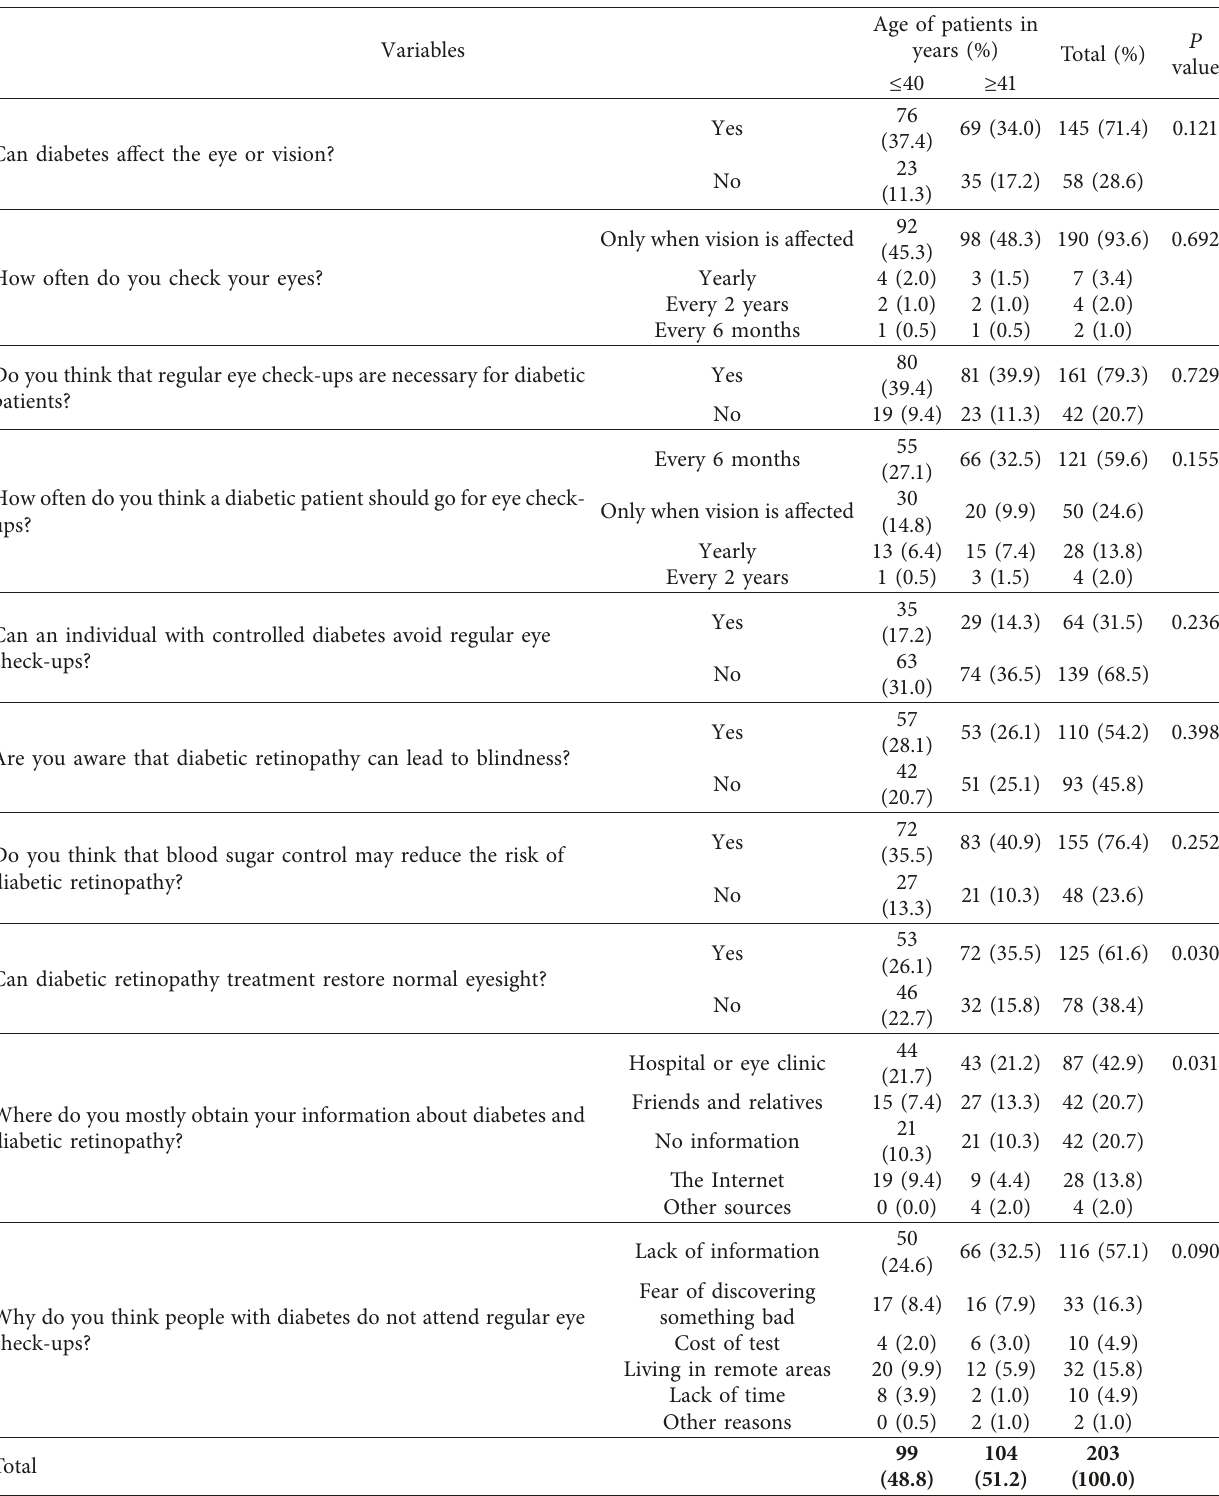
Table 2: Association between age and knowledge and awareness of DM and DR.